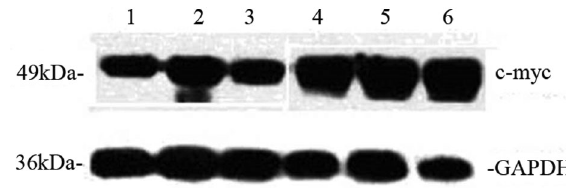
Figure 2. Expression of c-myc was significantly higher in the fetus group ( lanes 4,5,6 ) than in the control group ( lanes 1,2,3 ) by Western blot.